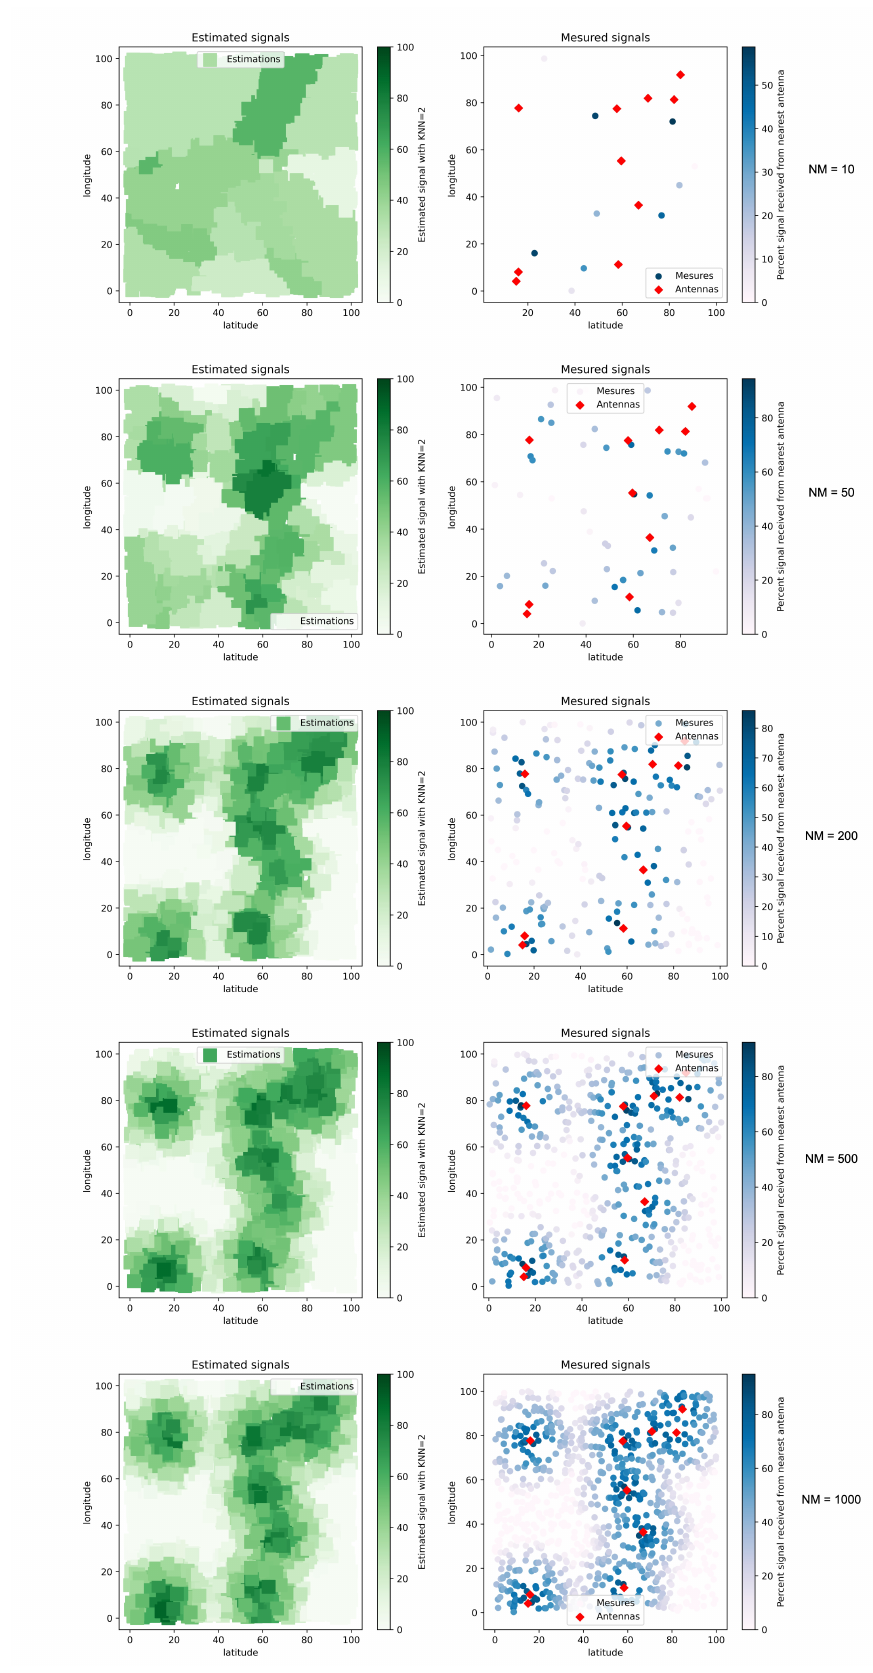
Figure 10. Signal estimations with different numbers of signal measures